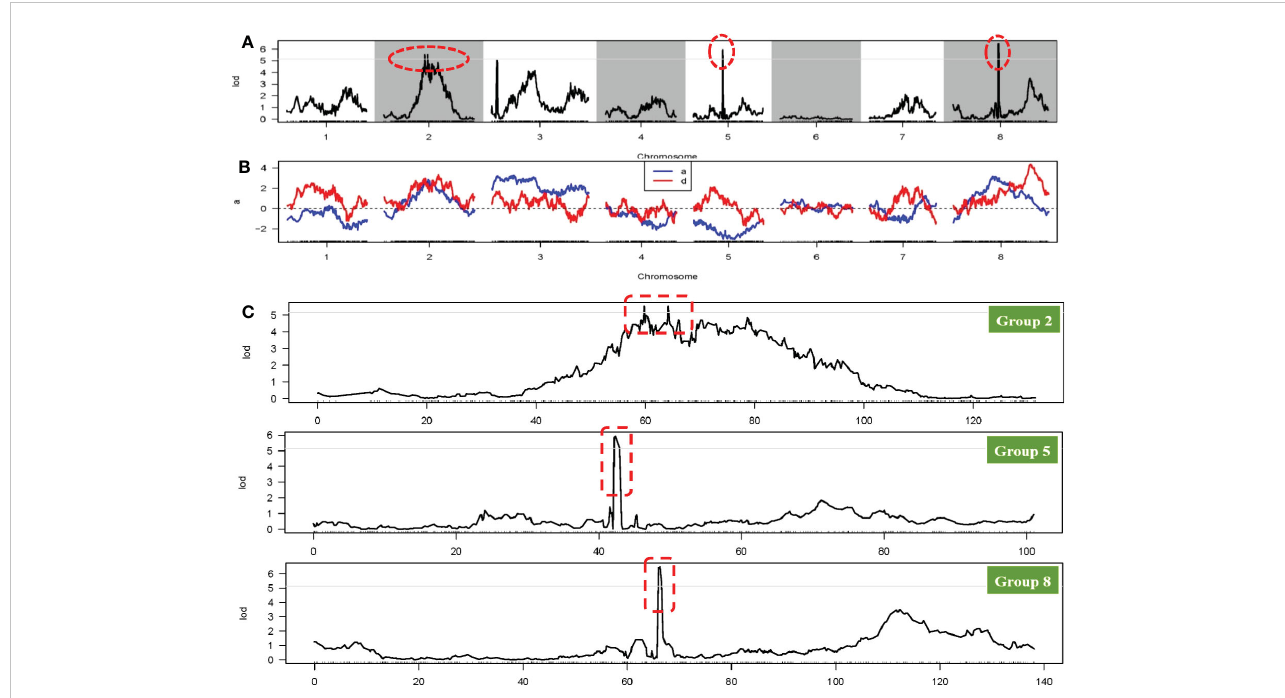
FIGURE 5 QTL locations of fl ower stalk height trait using the genetic map. (A) QTL analysis of the fl ower stalk height trait on eight linkage groups; (B) Phenotypic contribution rate for variation of the fl ower stalk height trait; (C) LOD scores for the QTLs of the fl ower stalk height trait on the 2 th , 5 th and 8 th LG. The red circle or box all indicate the QTL regions related to fl ower stalk height